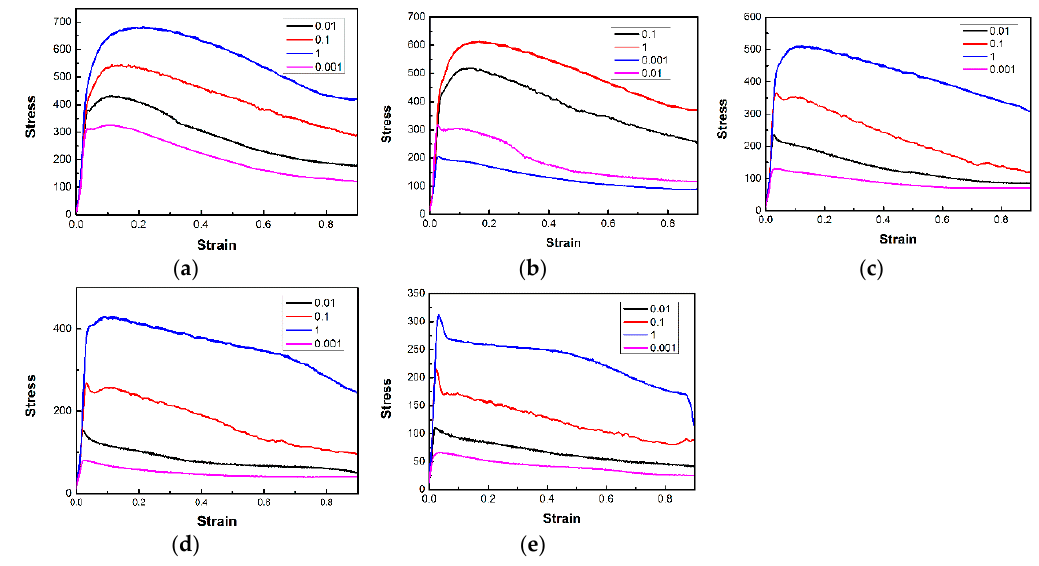
Figure 2. Flow curves of specimens deformed at ( a ) 1000 °C; ( b ) 1050 °C; ( c ) 1100 °C; ( d ) 1150 °C; ( e ) 1200 °C. Table 2. The critical strain of the present alloy deformed at different conditions.